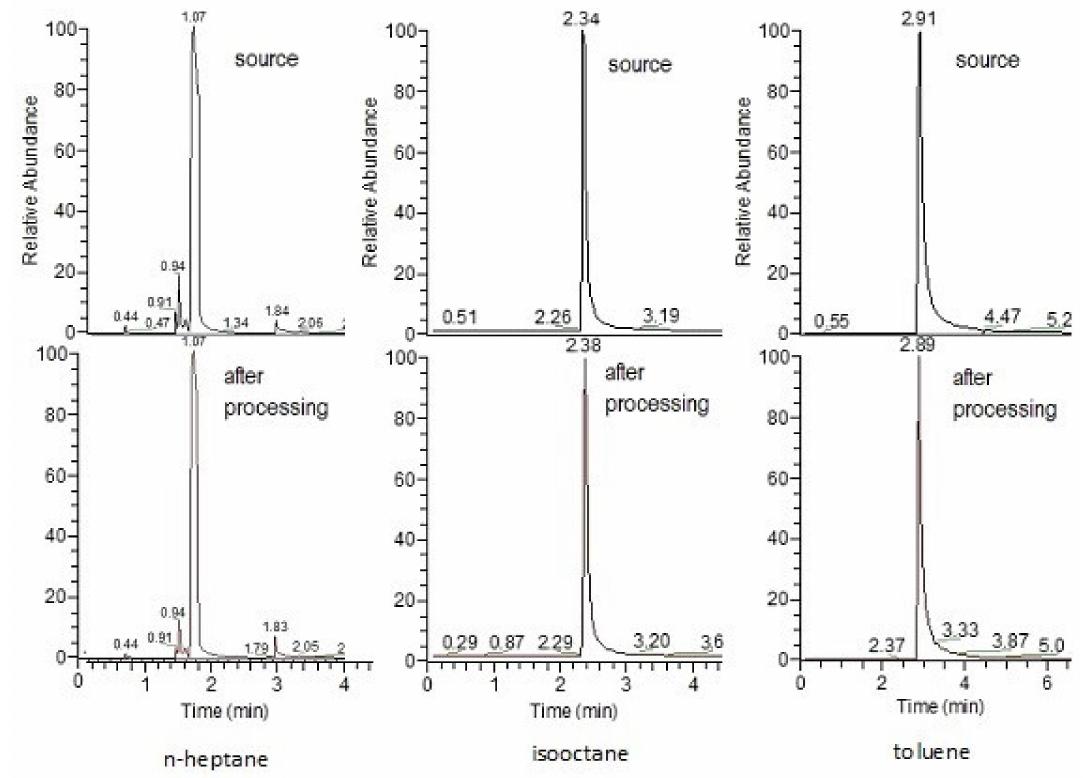
Figure 11. Examples of main components detected in: the source hydrocarbons ( top ); and processed hydrocarbons ( bottom